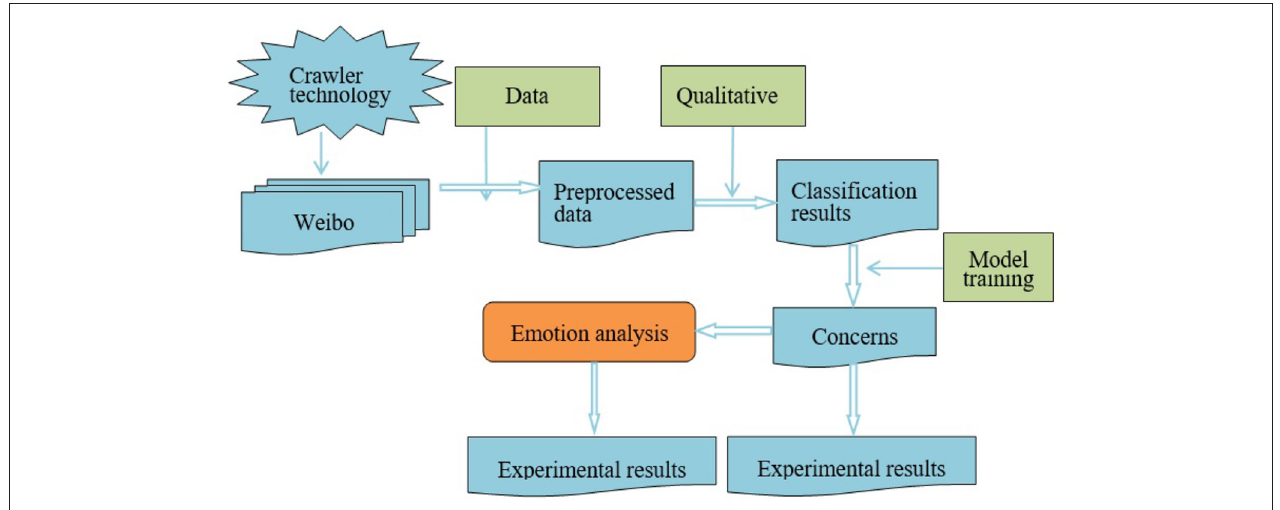
FIGURE 1 | The frame chart of migrant works’ concerns recognition and emotion